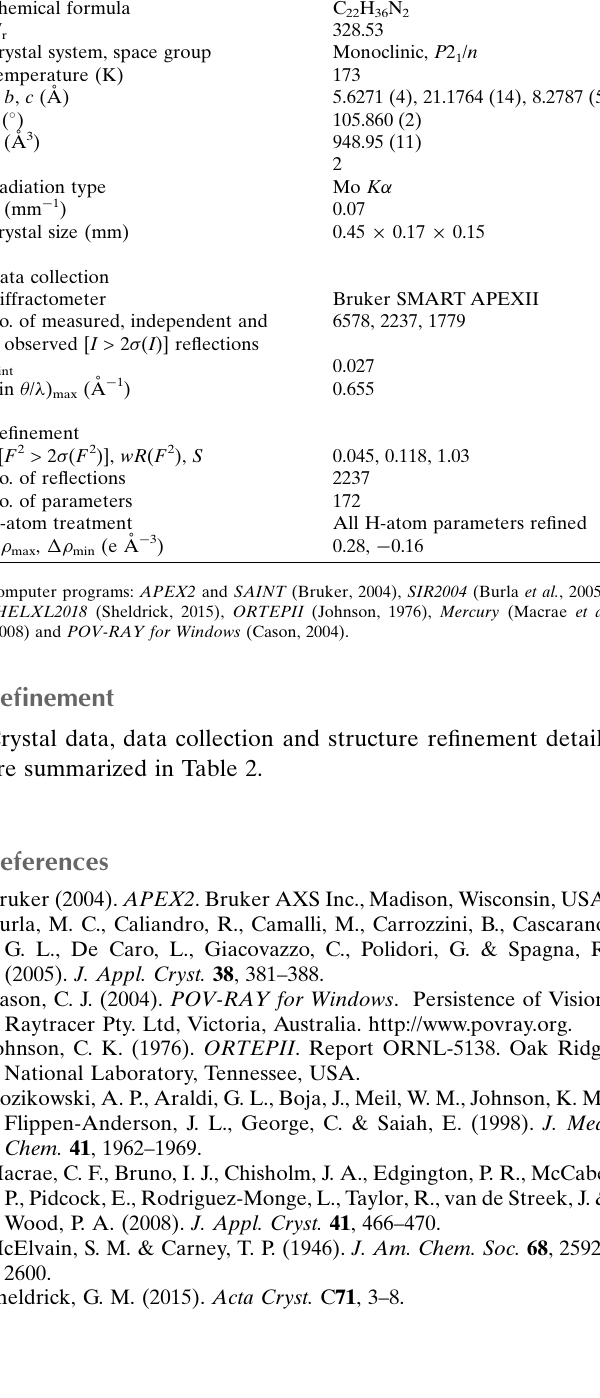
Table 2 Experimental details. Crystal data Chemical formula